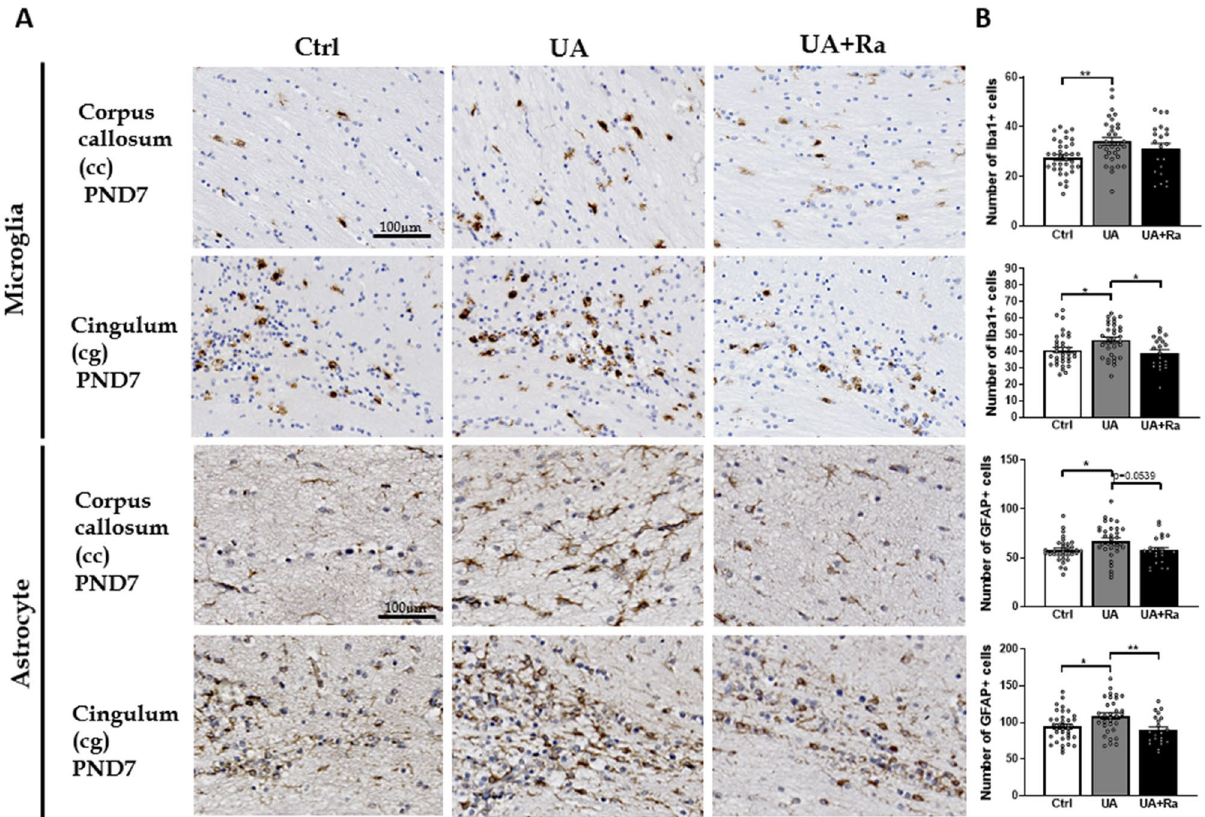
Figure 3. Histological analysis of Iba-1 and GFAP positive cell in the white matter following uric acid alone or with IL-1Ra prenatal treatment. Injection of uric acid during gestation increased the number of microglial cell and astrocytes in the corpus callosum and in the cingulum at PND7. Prenatal treatment with IL-1Ra reduced the number of microglia and astrocytes to a similar level than in the control group. Representative image shown in ( A ) and quantification in ( B ). N = 8–16 litters (i.e. PBS = 11; IL-1Ra = 8; UA = 16; UA + Ra = 12). *p < 0.05; **p < 0.01; ***p < 0.001 Results presented as mean ± SEM. Statistical analysis by one-way ANOVA with Tukey’s multiple comparisons test with GraphPad Prism 9.2.0 (GraphPad Software, CA); www. graph pad.